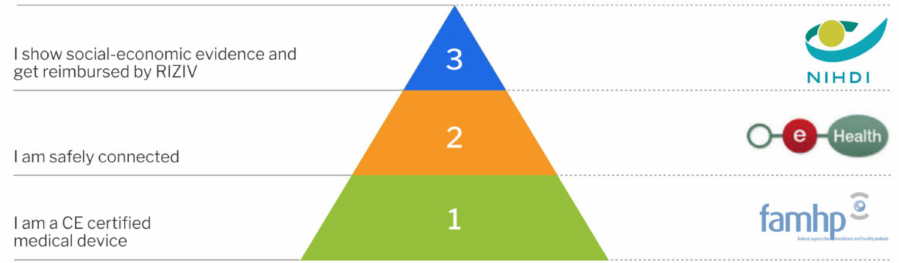
Figure 5. Validation Pyramid by mhealth Belgium, platform for CE-marked mobile health applica- tions in Belgium [61]. Reprinted with permission from ref [61]. Copyright 2020 Agoria vzw/asbl and beMedTech